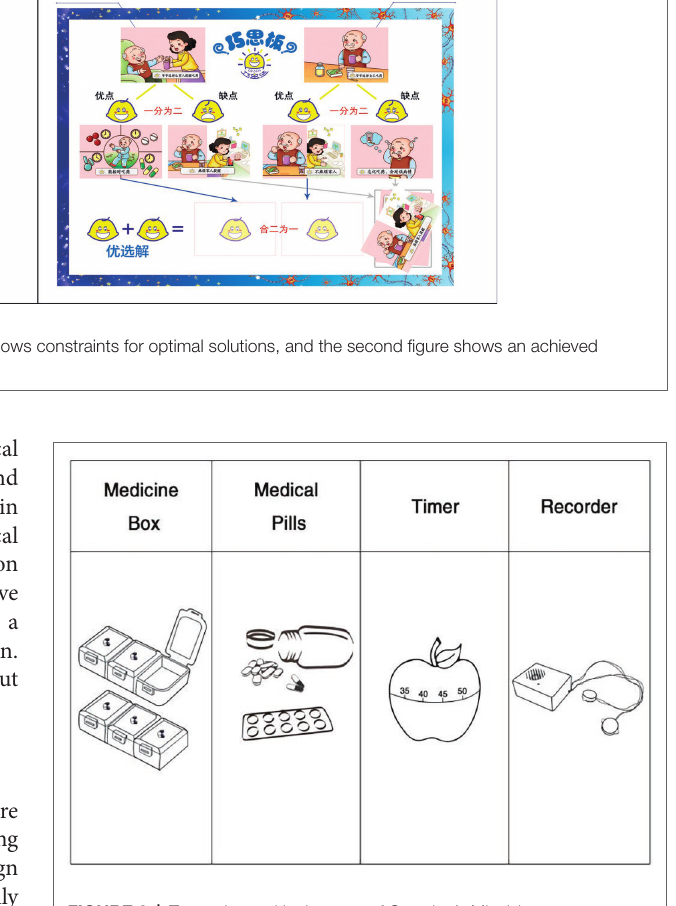
FIGURE 3 | Toy tools used in the case of Grandpa’s